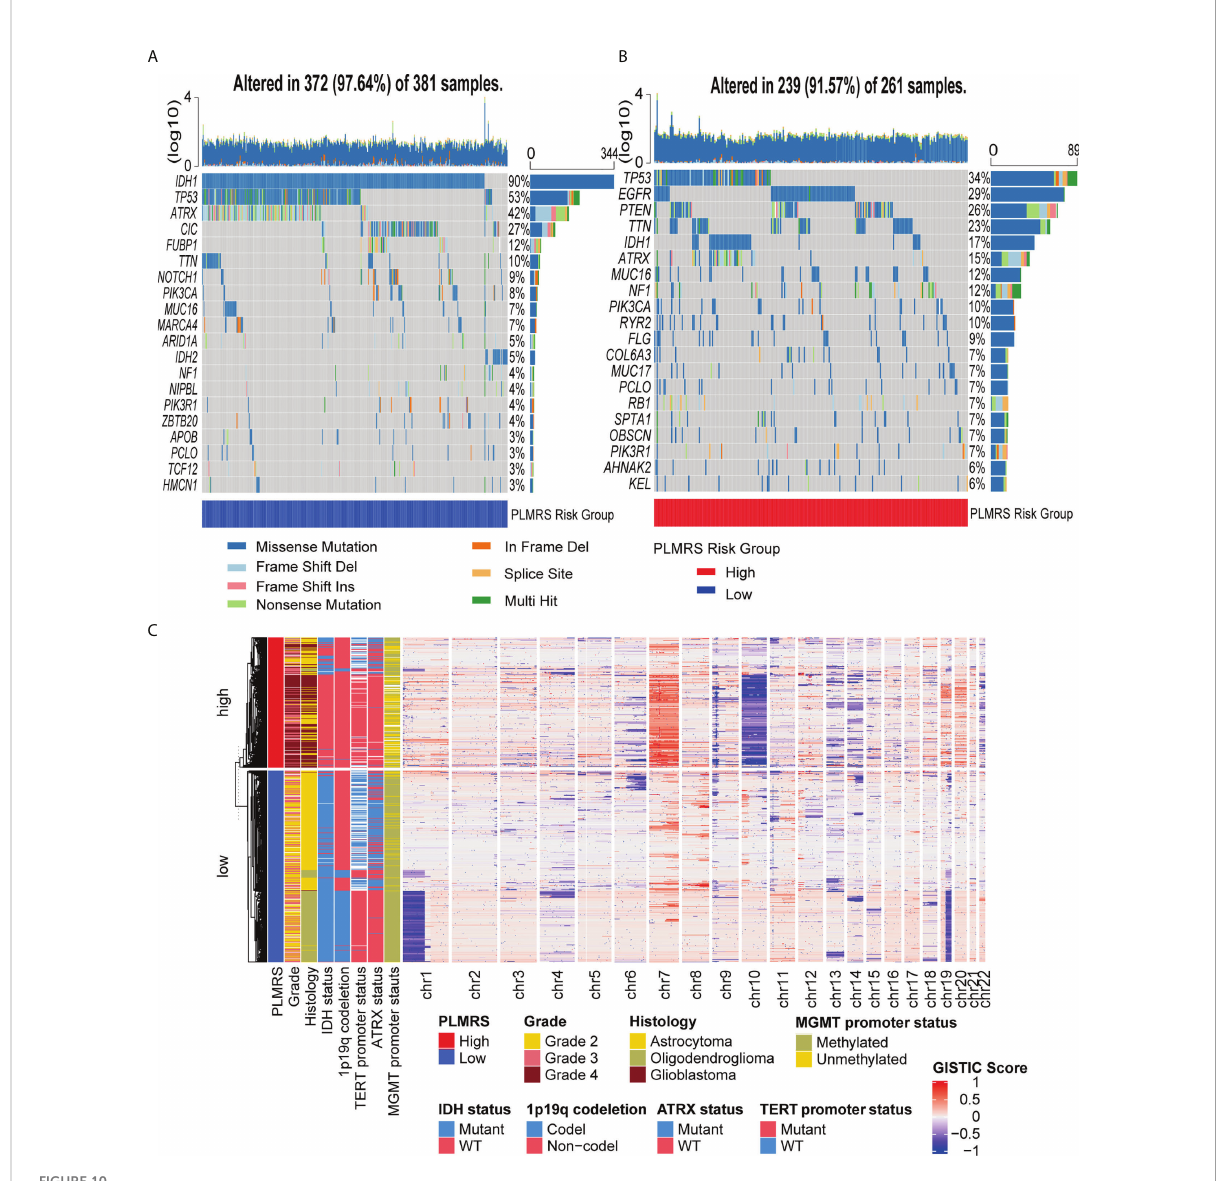
FIGURE 10 Somatic mutations and CNV of two risk groups. Top 20 somatic mutations in low-risk group (A) and high-risk group (B) . (C) Landscape of autosomal CNV in two risk groups. CNV, copy number variation; TCGA, The Cancer Genome Atlas; PLMRS, prognostic lactate metabolism risk score; IDH, isocitrate dehydrogenase; TERT, telomerase reverse transcriptase; ATRX, Alpha Thalassemia Developmental Delay; MGMT, O6- methylguanine-DNA methyltransferase; GISTIC, Genomic Identi fi cation of Signi fi cant Targets in